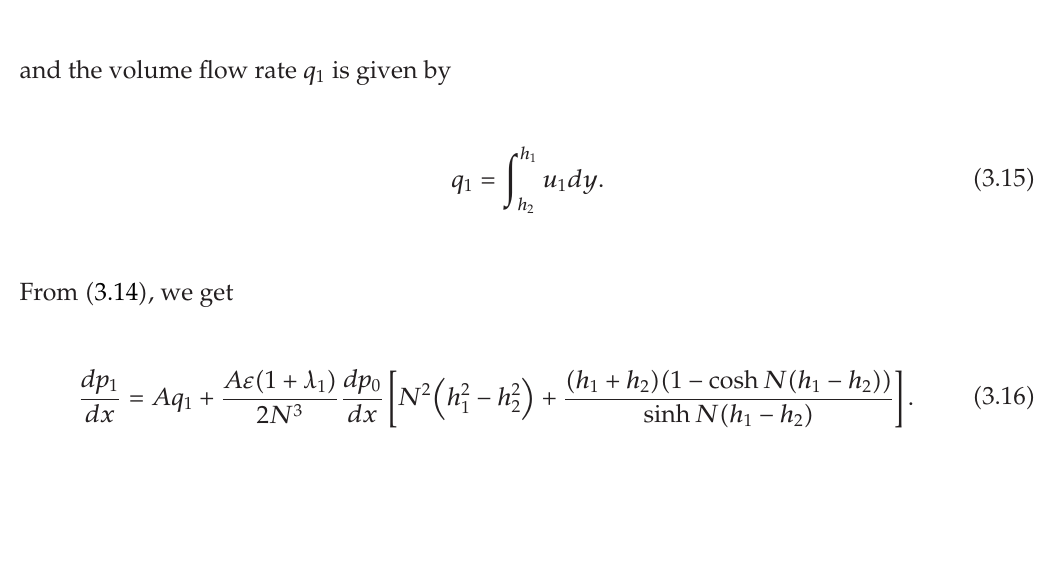
Figure 6: The pressure rise verses flow rate when α (cid:9) 0 . 01 , b (cid:9) 0 . 6 , d (cid:9) 0 . 8 , ε (cid:9) 0 . 3 , λ 1 (cid:9) 0 . 4, Da (cid:9) 0 . 5, and φ (cid:9) π/